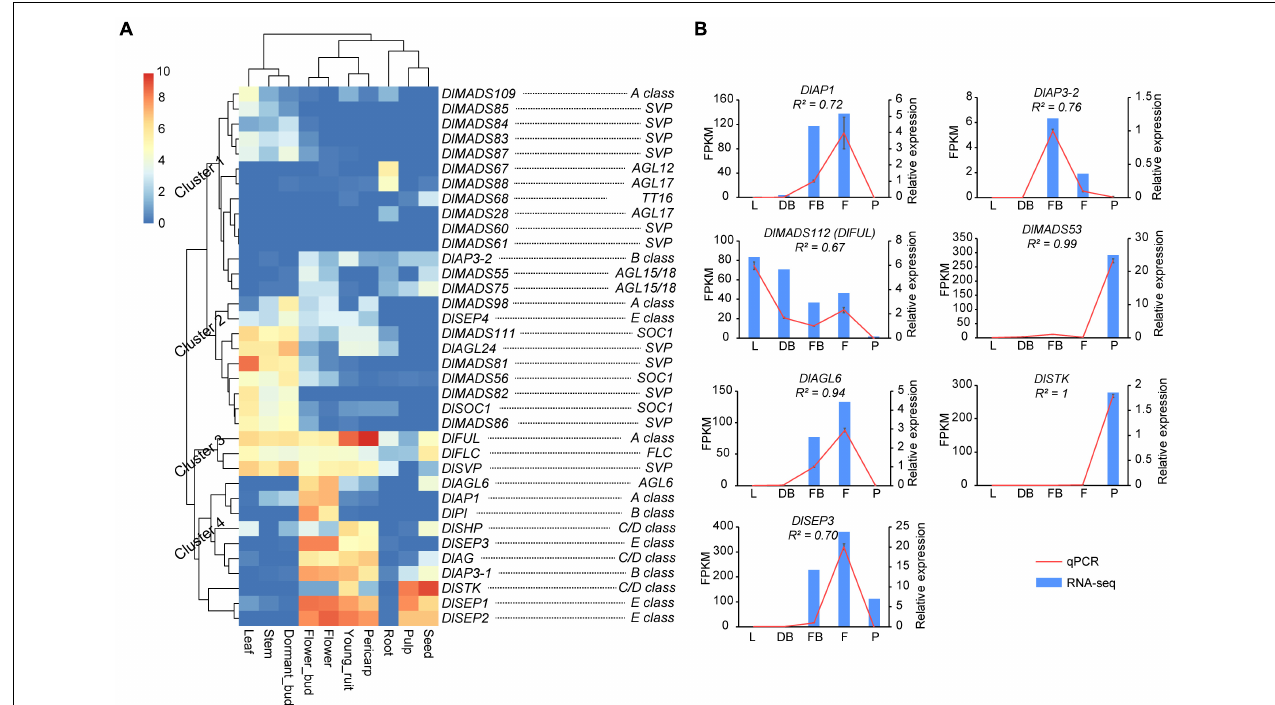
FIGURE 7 | The expressional pattern of MIKC C genes in longan. (A) Expression heat maps of MIKC C genes in nine tissues (root, stem, leaf, dormant bud, flower bud, flower, fruit, pericarp, and seed) of “SJ” longan Expression values were normalized by log 2 (FPKM+1). (B) Detection of MADS-box genes in longan based on qRT-PCR. Six MADS-box genes were selected to detect the expression level in leaf (L), dormant bud (DB), floral bud (FB), flower (F), and pulp (F) of “XC” longan. Data were normalized to Actin1 and Actin2 genes, and the vertical bars indicate standard deviation.